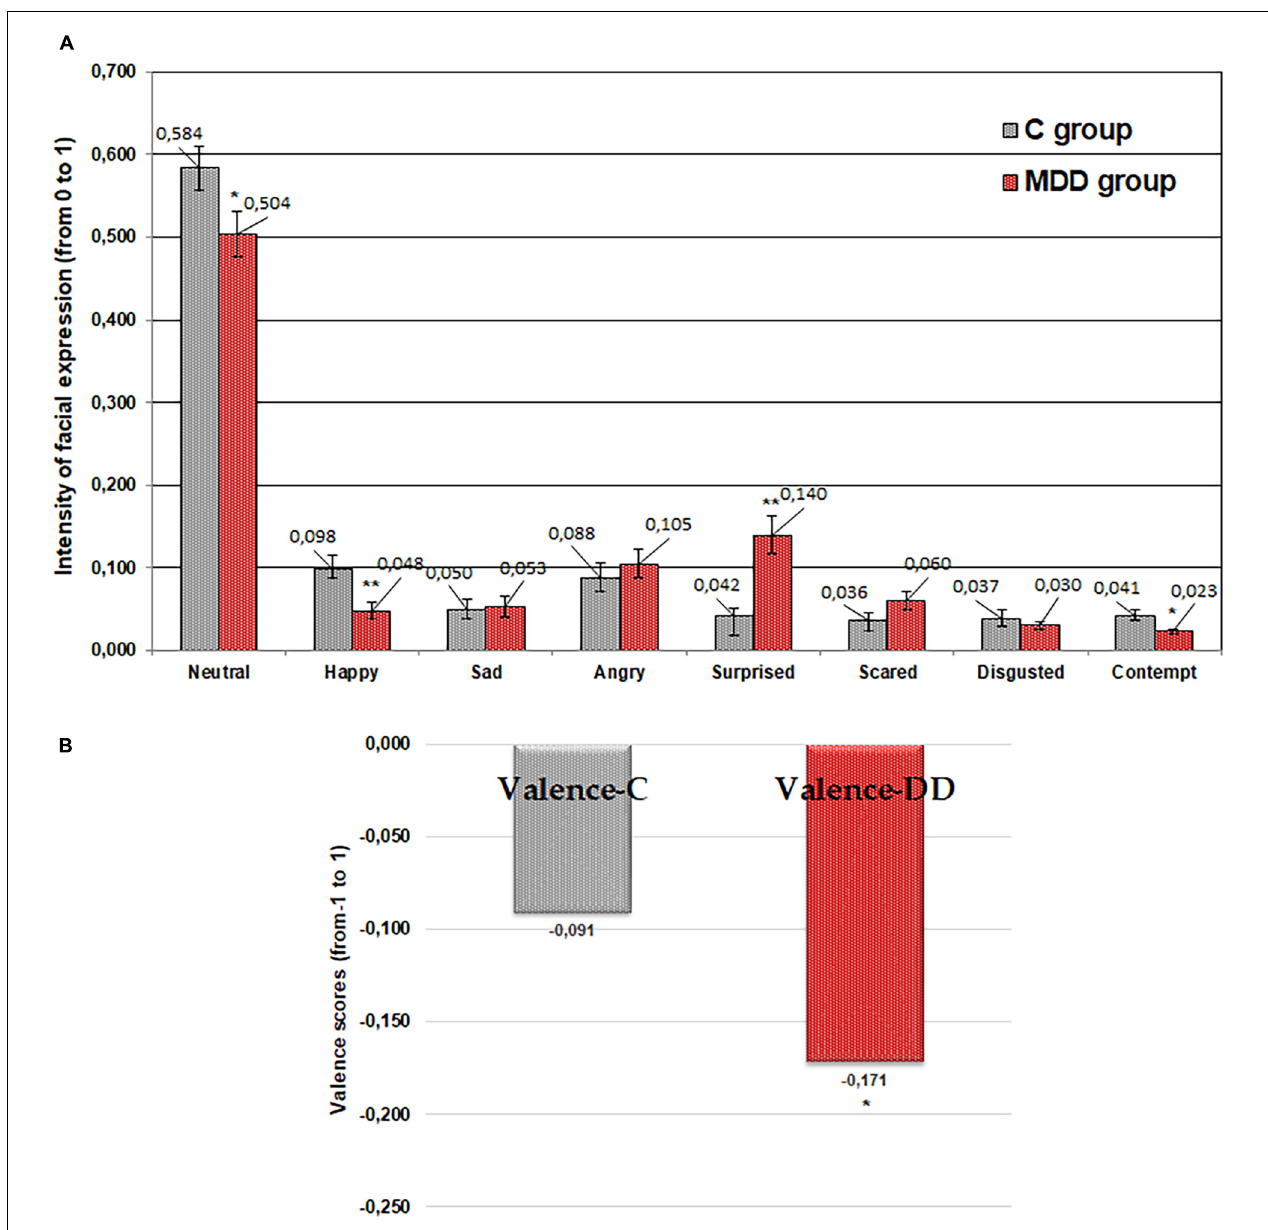
FIGURE 5 | Emotions (“neutral,” “happy,” “sad,” “angry,” “surprised,” “scared,” “disgusted,” and “contempt”) induced by imagined “sour” tasting food (A) and valence (B) for patients with major depressive disorder (MDD group) and without MDD (C group). Significant difference between groups: *p ≤ 0.05; **p ≤ 0.01.